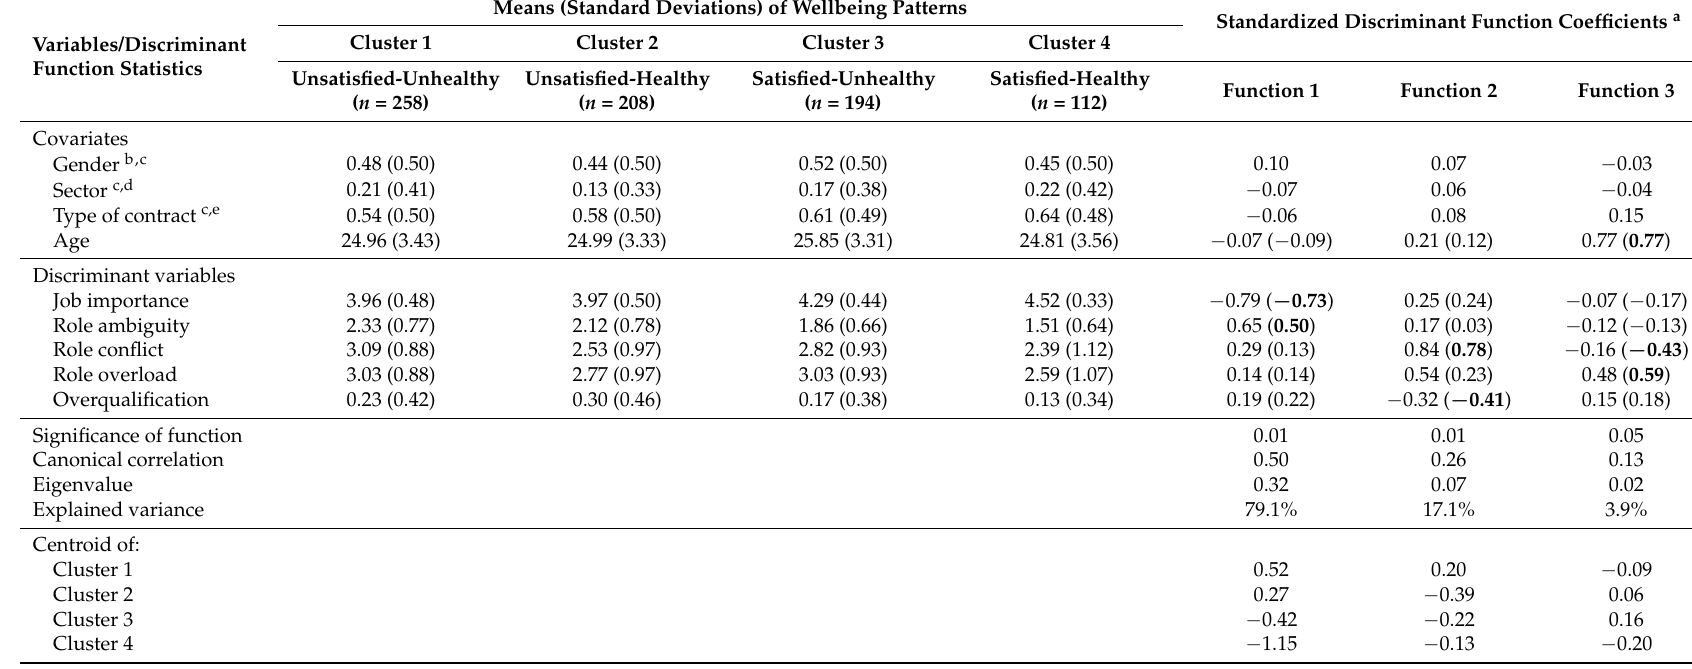
Table 2. Discriminant analysis of the four patterns of relations between job satisfaction and mental health with job importance, role ambiguity, role conflict, role overload, and overqualification as discriminant